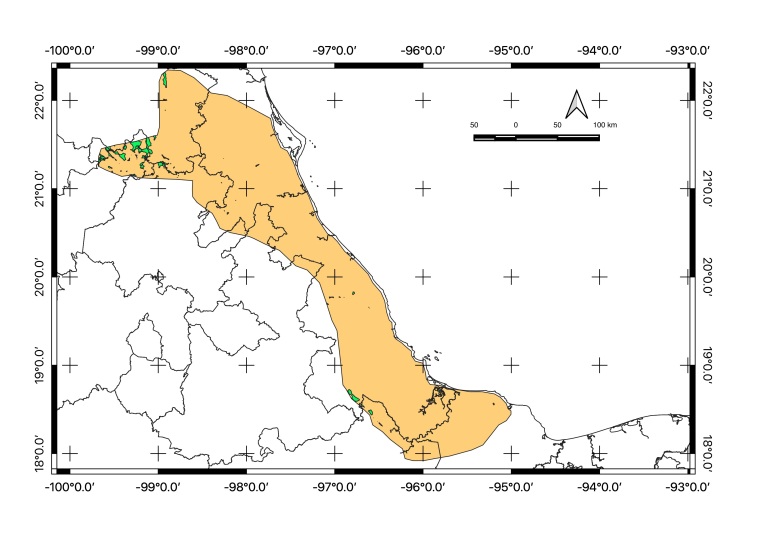
Habitat quality across the distribution of Brachypelma
kahlenberghi Rudloff, 2008. Low quality habitat areas (LQH) in orange and high quality habitat areas (HQH) in green (for estimation details, see formula in Methods).